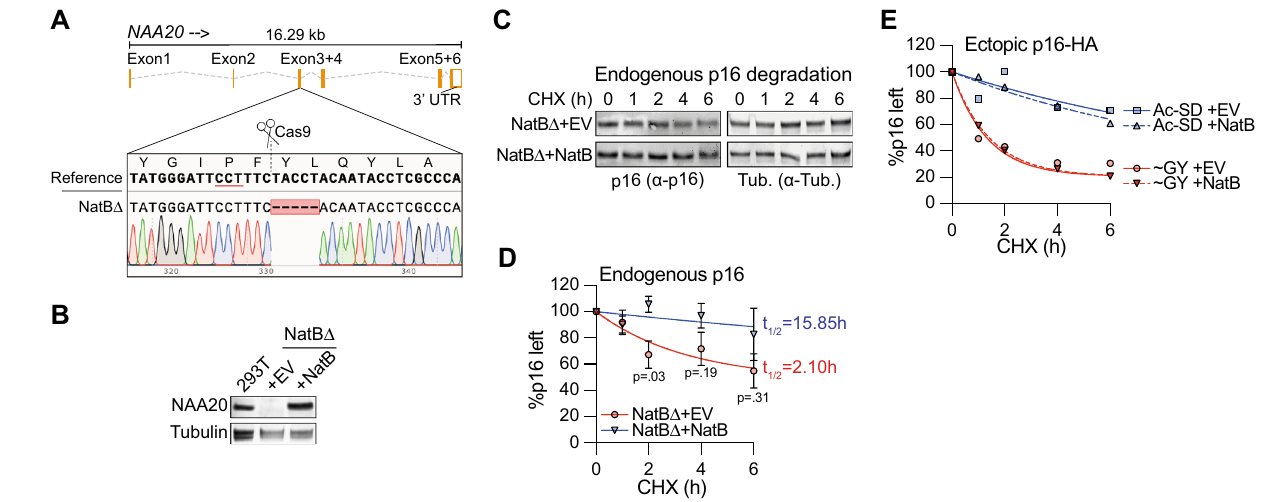
Figure 6. Nt-acetylation, not N-terminal sequence, determines p16 protein stability. ( A ) The region surrounding the Cas9 target site in the NAA20 gene was PCR-amplified from a clonal NatBΔ HEK 293T cell line and analyzed by sequencing. Shown is the NAA20 gene structure, inset shows a zoom of the Cas9-target site with the PAM sequence underlined in red. ( B ) Immunoblot analysis of lysates from the HEK 293T parental cell line, and the clonal NatBΔ HEK 293T cell line reconstituted with either an empty vector (+ EV) or NAA20 cDNA (+ NatB). ( C , D ) HEK 293T NatBΔ cells, reconstituted with either an empty vector (+ EV) or with NAA20 cDNA (+ NatB), were treated with CHX for indicated time periods, followed by immunoblot analysis of endogenous p16 protein levels. Tubulin was used as a stable protein and loading control. A representative Western blot image is shown in panel C. Panel D shows the quantification, which was done by normalizing the p16 signal to the Tubulin signal, the 0 h time point was set to 100%. Data were fitted by a one-phase decay curve fit, which was used to quantify the half-life (t 1/2 ). P-values are derived by statistical testing between the values in the + EV and + NatB samples at each time point (n = 3; mean ± SEM; Unpaired t-test, two-tailed). ( E ) As in panel D, but for ectopically expressed p16-HA variants (n = 3; mean ±